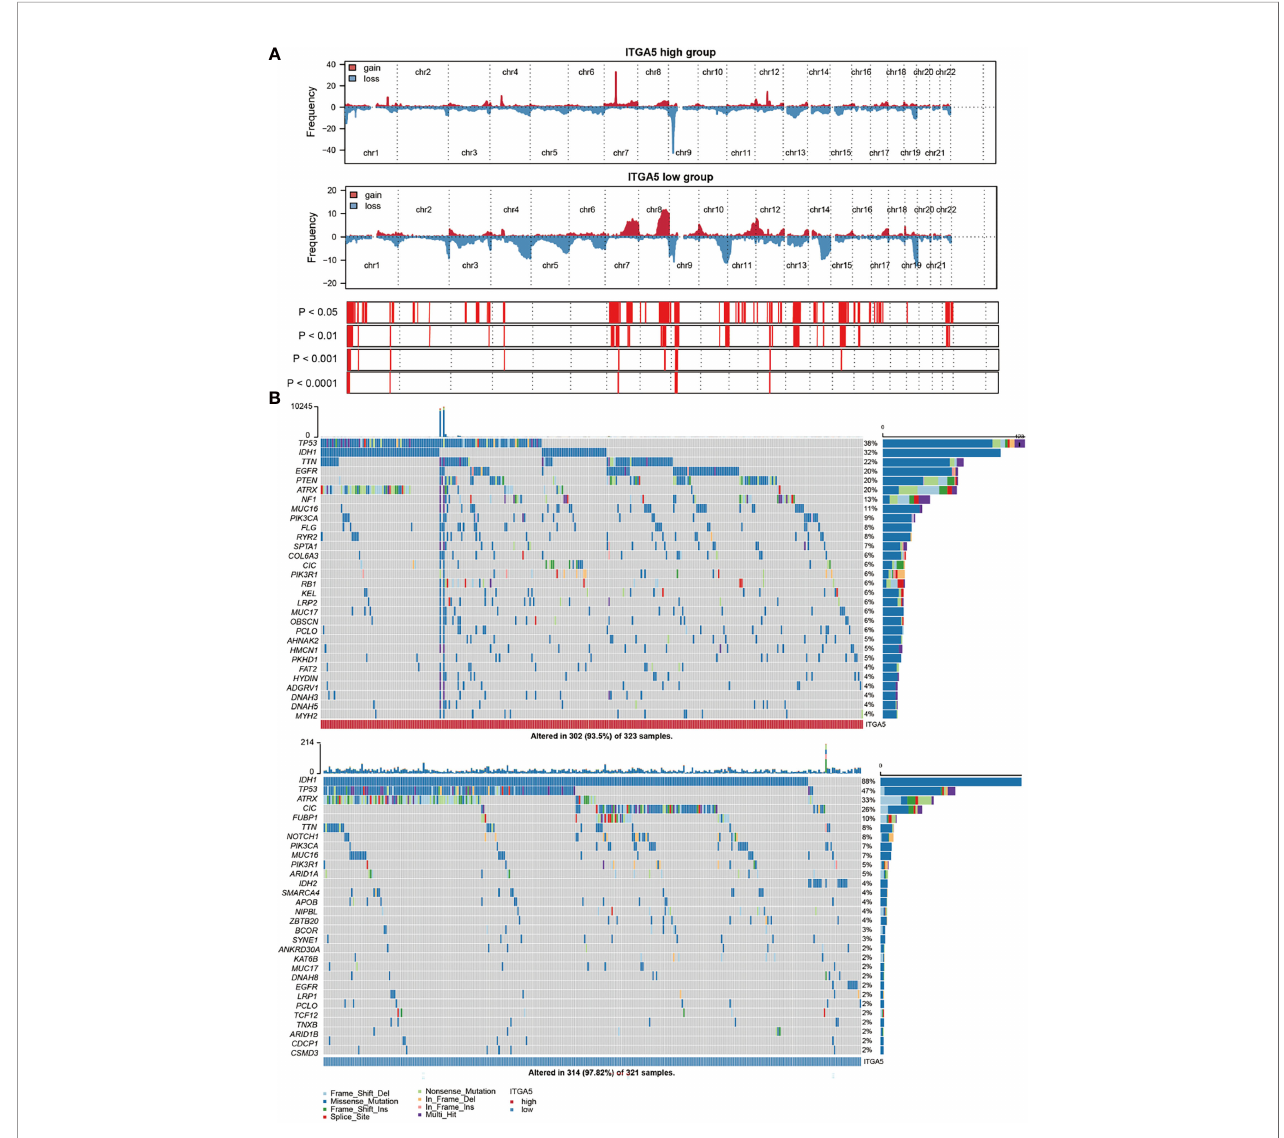
FIGURE 4 | ITGA5-associated genomic alterations in gliomas samples. (A) Main copy-number changes in gliomas with high and low ITGA5 expression. (B) Somatic mutations detected in gliomas with high and low ITGA5